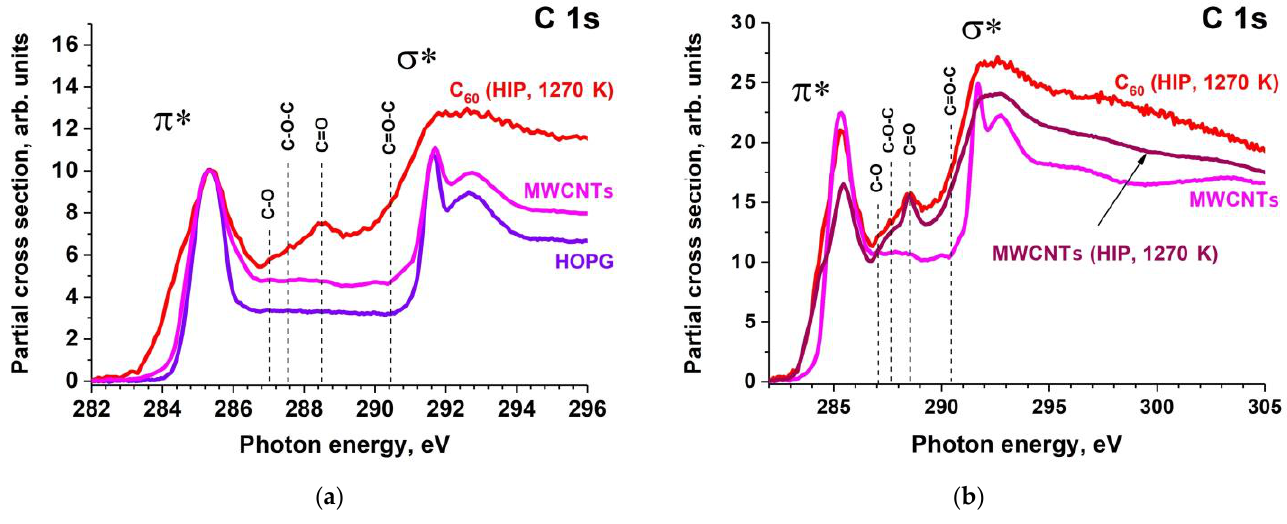
Figure 5. C 1s NEXAFS spectra of HOPG, MWCNTs and fullerite C 60 HIP-treated at 1270 K, ( a ) normalized the π* peak maximum and ( b ) normalized to the photoabsorption cross section at the photon energy of 320 eV.